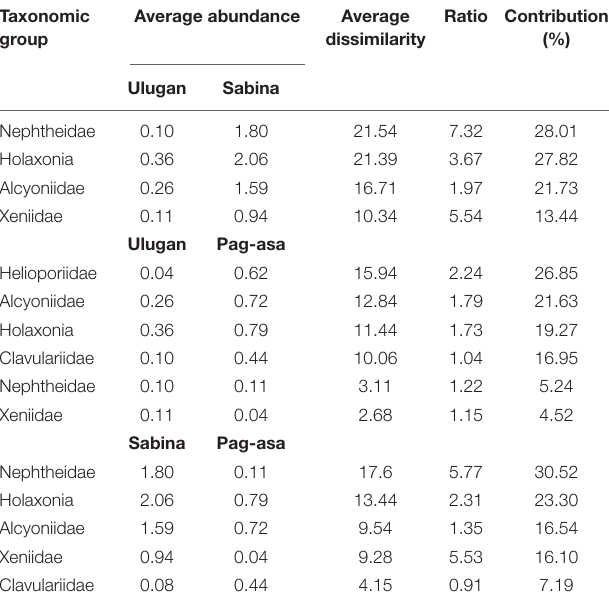
TABLE 5 | Dissimilarity percentages among sites from the SIMPER analysis among sites in the Kalayaan Island Group and Ulugan in 2019. Taxonomic Average group